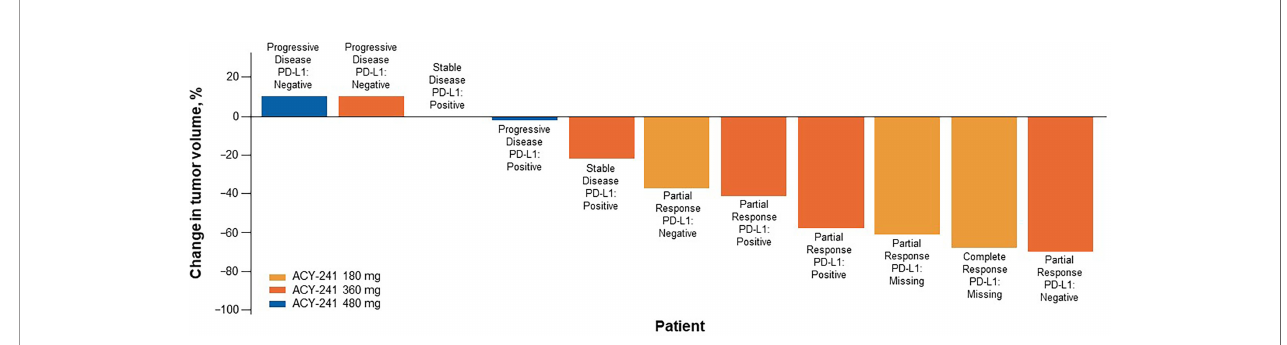
FIGURE 2 | Sum of tumor shrinkage and best response per RECIST v1.1 (n = 11). Tumor shrinkage measured from baseline. One response-evaluable patient received fi rst dose of nivolumab but had progressive disease before fi rst tumor assessment and was excluded here. PD-L1, programmed death ligand 1; RECIST, Response Evaluation Criteria in Solid Tumors.